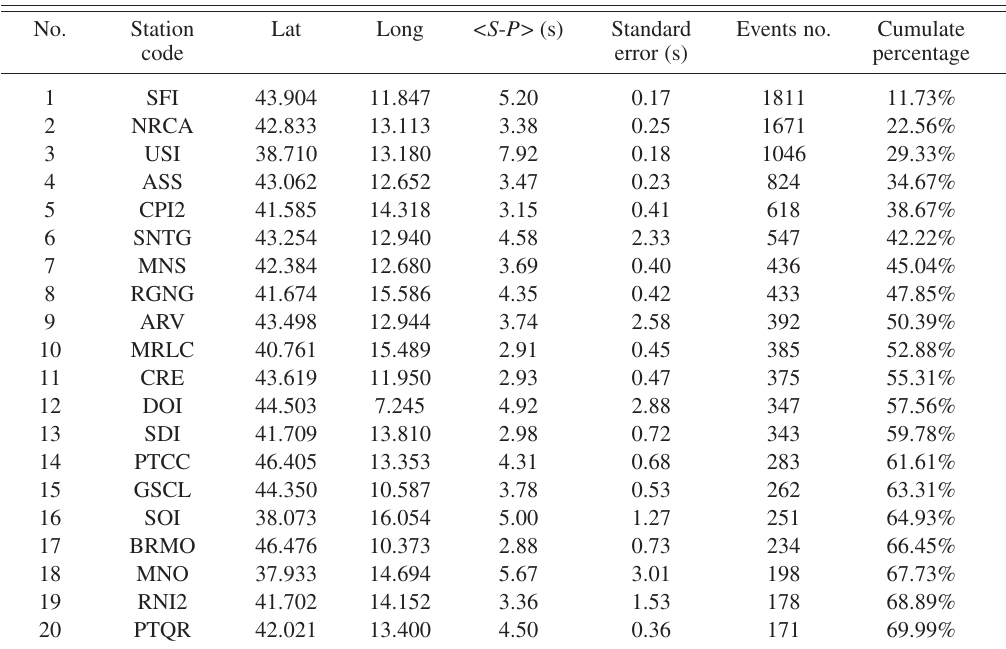
Table I. Median and estimated standard error of S - P delays measured at the closest station for the 15437 not- located earthquakes that occurred in 2000-2002. «Events no.» is the number of not-located earthquakes, and «cu- mulate percentage» is relative to the totality of the